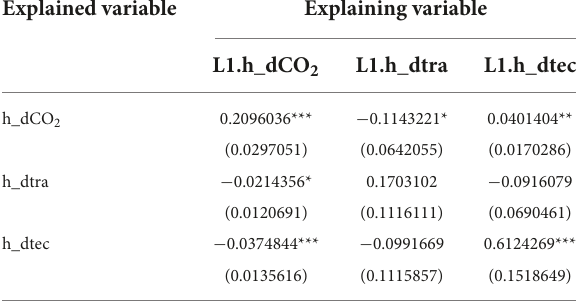
TABLE 5 GMM estimation results of PVAR model.